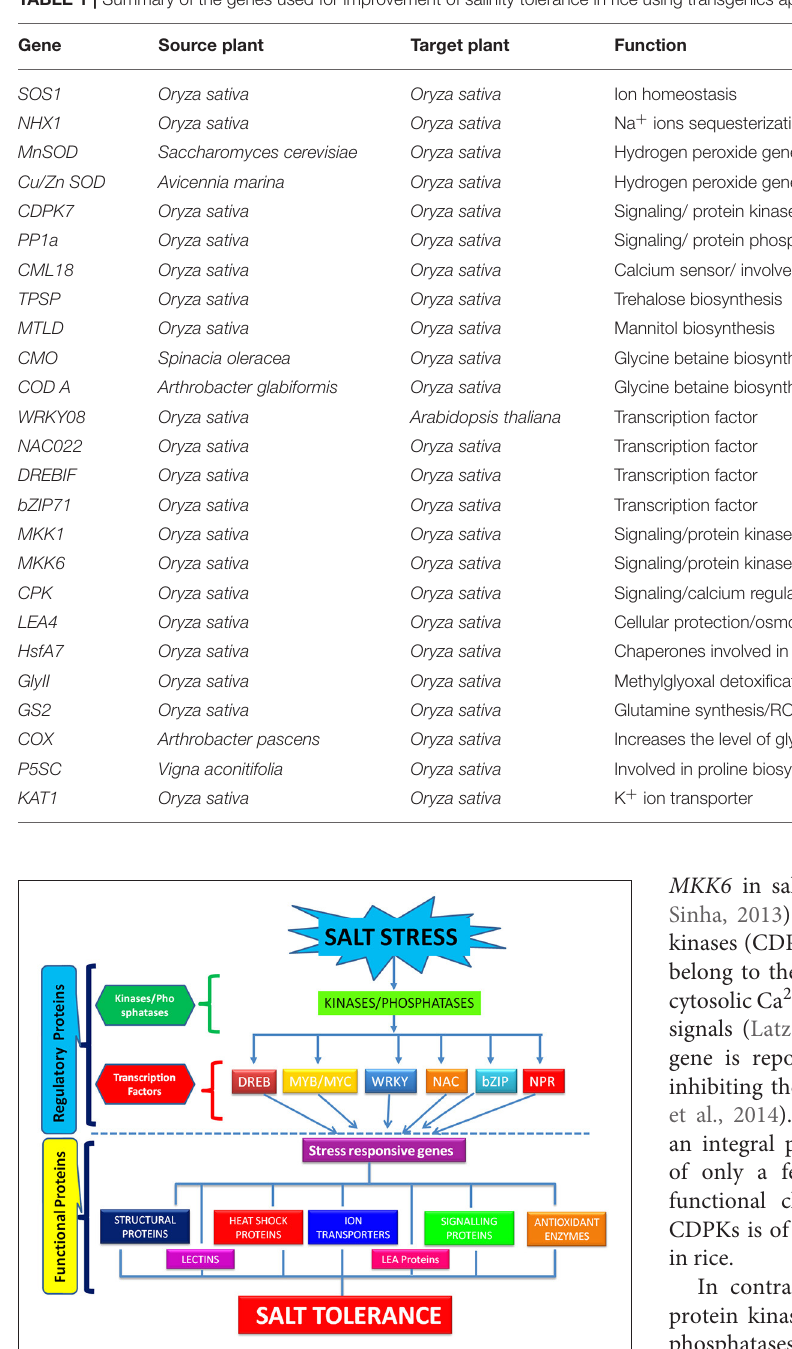
FIGURE 2 | Molecular regulation of salt stress tolerance through regulatory and functional